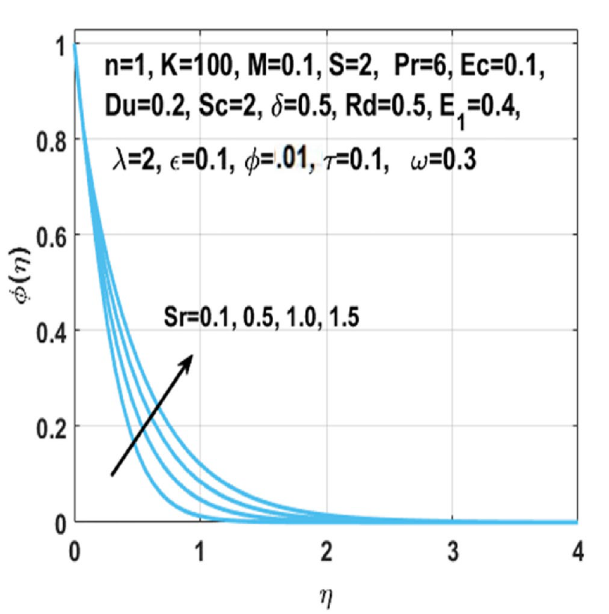
Figure 6. Impact of Pr on θ(η) .